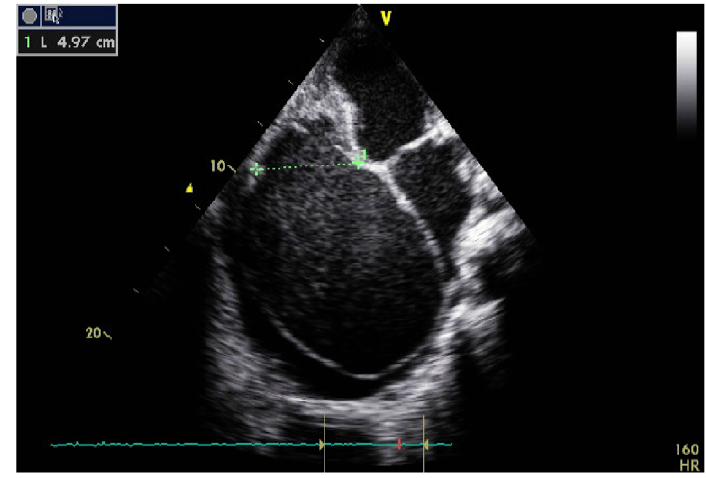
Figure 3. Echocardiographic features of predominant right endomyocardial fibrosis are shown in this picture, namely obliteration of the right ventricle with reduction of cavity volume, tricuspid annulus dilatation, aneurismal right atrium with spontaneous contrast. There is compression of the left cavities, thickening of the mitral leaflets and pericardial effusion.